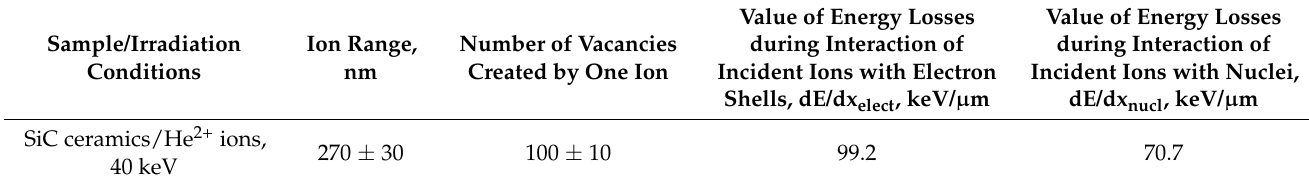
Table 1. Energy loss data in SiC